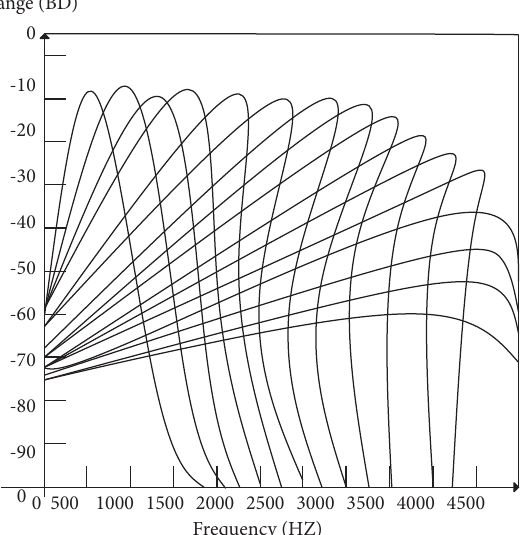
Figure 4: Gammatone function amplitude-frequency response curve at different center